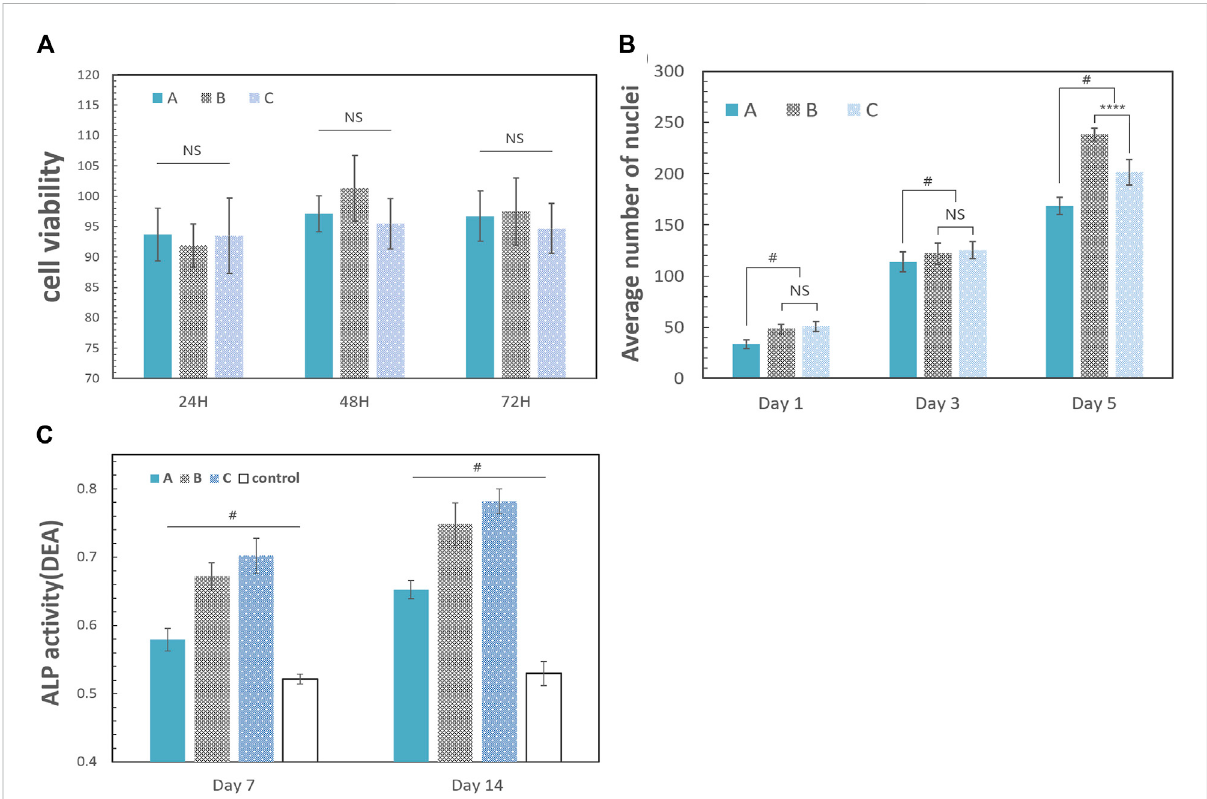
FIGURE 8 Biological properties of the scaffold. The error bar represents the standard deviation of the sample. (A) Results 24, 48, and 72 h after coculture withleach liquors[A:group A(10% HCP);B:groupB(30% HCP);andC:group C(50%HCP)].Thedifferencebetweeneachgroup wasnotstatistically signi fi cant (one-way ANOVA, F = 0.6906, p = 0.6951, and n = 5). (B) Cell proliferation analysis of the scaffolds. The data were the average number of nuclei after cell counting with ImageJ software. The number of proliferating cells in group A was generally fewer than the other two groups. There were no signi fi cant differences between group B and group C on the 1st and 3rd day (one-way ANOVA, for 1st day: F = 1.341; p = 0.3924 and n =5;for3rd day: F =1.582; p =0.5188and n =5).ThecelldensityingroupBincreasedrapidlyfromthe3rd daytothe5th day,whichwasmorethan that in group C (one-way ANOVA, F = 4.216; p < 0.0001 and n = 5). (C) ALP activity on days 7 and 14. A: group A (10% HCP); B: group B (30% HCP); C: groupC(50%HCP);control:onlyCMCandgelatin.DEAisde fi nedasperthemanualoftheALPassaykit:theamountofALPrequiredtohydrolyzethe chromogenic substrate (para-nitrophenyl phosphate) in diethanolamine (DEA) buffer (pH 9, 37 ° C), producing 1 μ mol p-nitrophenol per minute, is de fi ned asone enzymeactivityunit,calledoneDEA(one-way ANOVA, F =71.56; p < 0.05and n =5).( “ # ” representsasigni fi cantdifference between each group; * p < 0.05; ** p < 0.01; *** p < 0.001; **** p < 0.0001; “ NS ” represents no signi fi cant differences between each